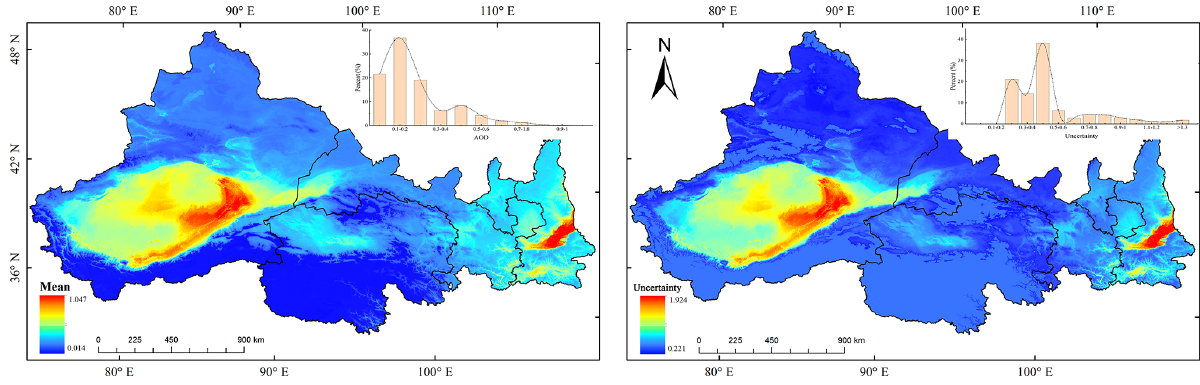
Figure 12. Distributions of the mean values and uncertainties in the AOD prediction